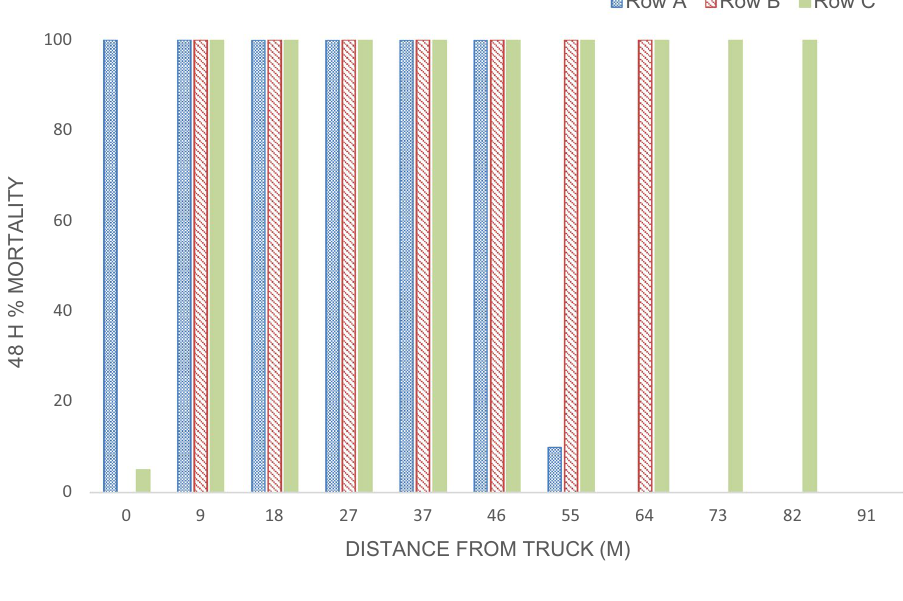
Fig. 6 Droplet characteriza- tion: A1 Mister VectoBac WDG application open-field trial larval bioassay using L3 Aedes aegypti (USDA) June 3, 2020 Sunny Shores, Cortez,